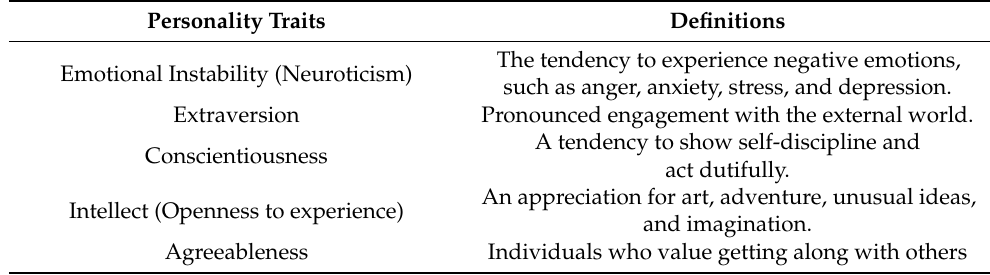
Table 1. Definitions for the Big Five personality traits [23,24]. Personality Traits